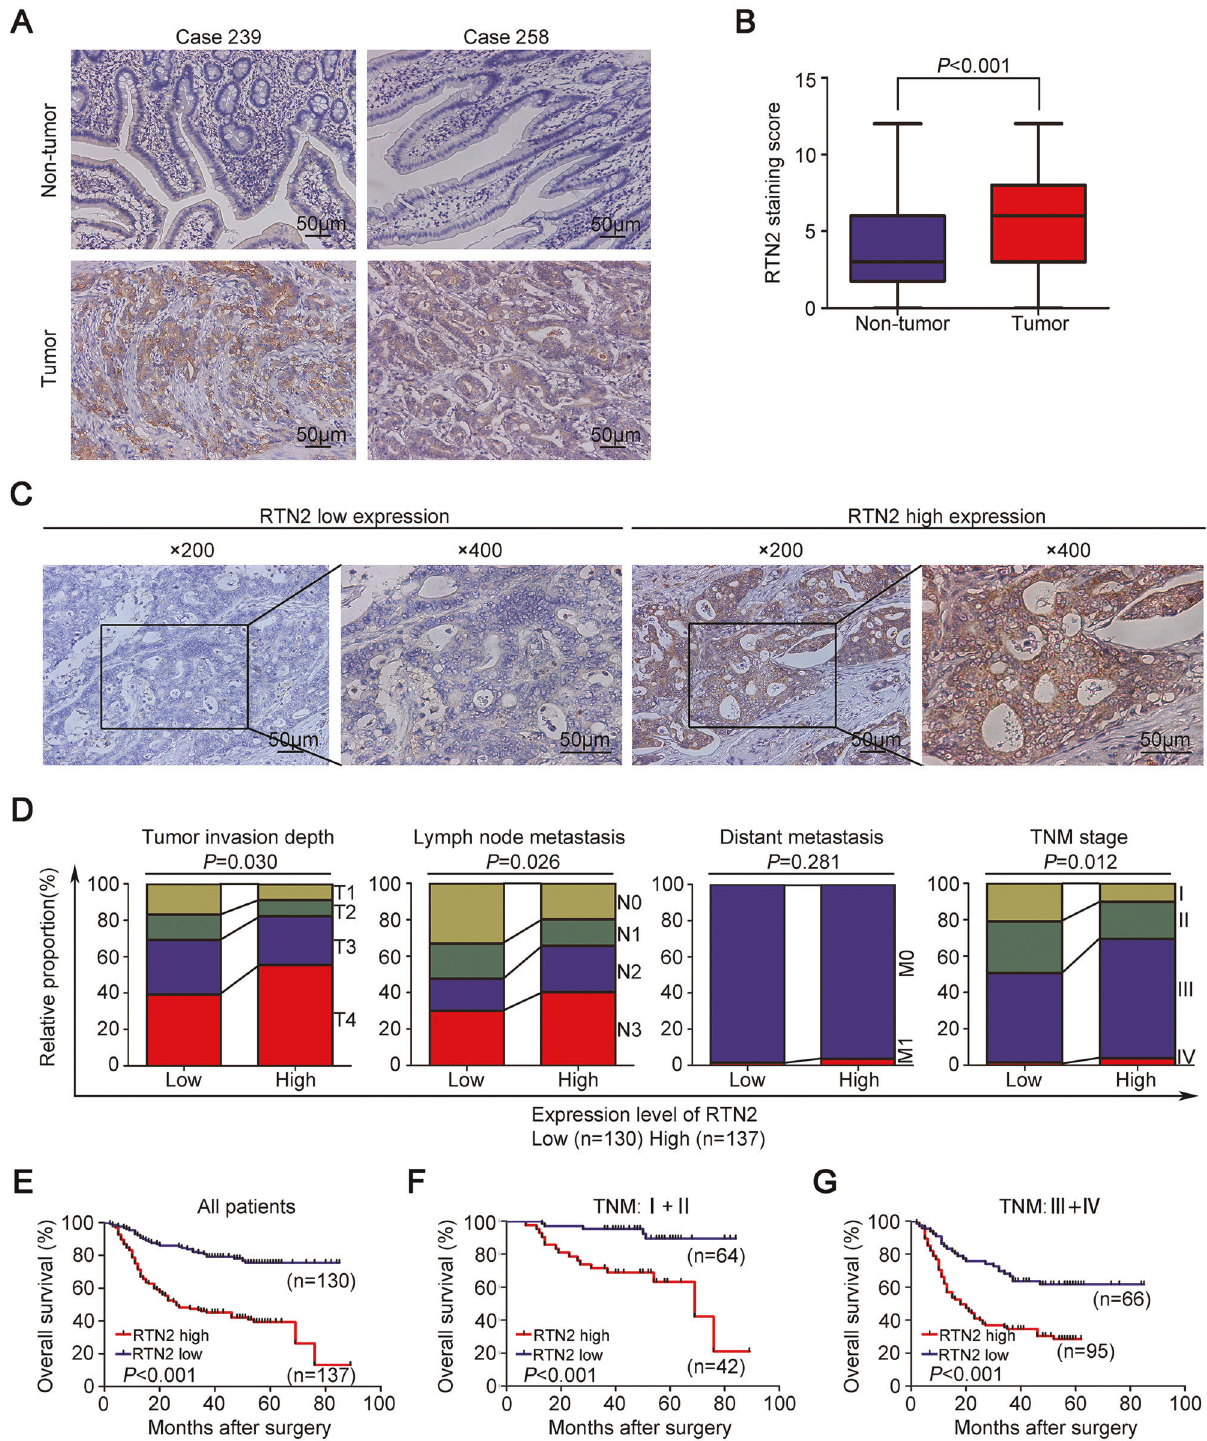
Fig. 1 High expression of RTN2 is correlated with tumour progression and adverse prognosis in gastric cancer patients. A Representative IHC staining of RTN2 in tumour tissue and matched non-tumour tissue of gastric cancer patients. B The comparison of RTN2 staining score in tumour tissue and matched non-tumour tissue of gastric cancer patients. Data are represented as min-to-max bar graphs with median lines. C The representative low and high expression of RTN2 in tumour tissues. D Correlation of RTN2 expression pattern with tumour invasion depth, lymph node metastasis, distant metastasis, and TNM stage in clinical gastric cancer cases. E – G Association of RTN2 expression in gastric cancer with overall survival was analysed by Kaplan – Meier survival curve for all patients ( E ), patients at TNM I + II stage ( F ), and patients at TNM III + IV stage ( G ), respectively. Statistical signi fi cance was calculated by Student ’ s two-tailed t test ( B ), Pearson χ 2 test ( D ) and log-rank test ( E – G ).